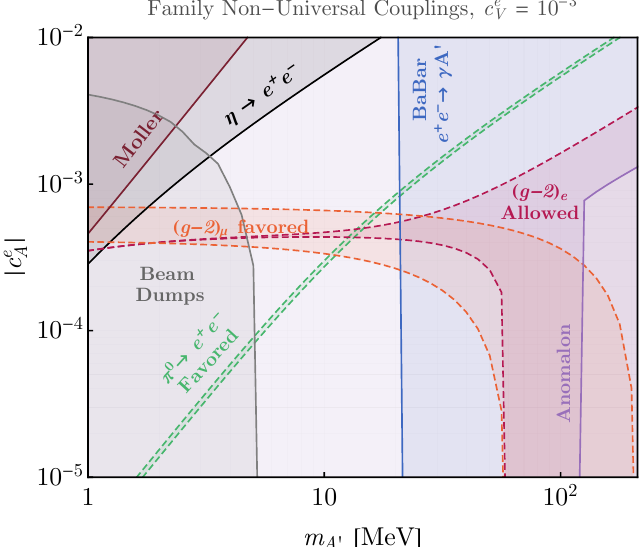
Figure 5 . Constraints on couplings with non-renormalizable Yukawa couplings, in the family non-universal